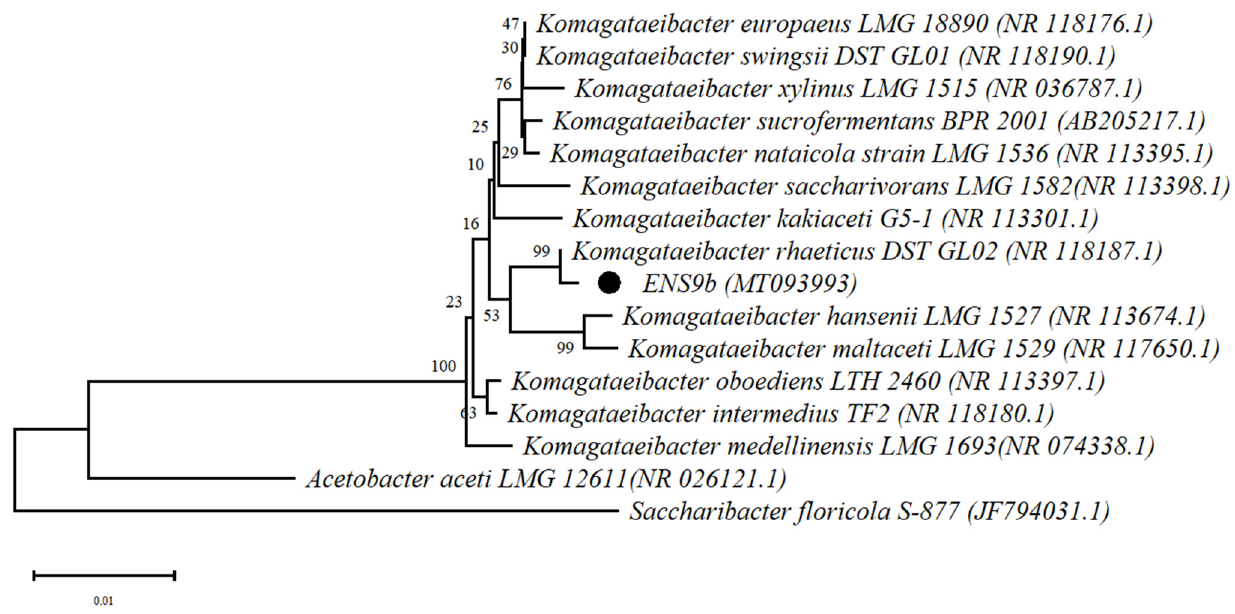
Figure 1. Phylogenetic relationship of ENS9b and Komagataeibacter type strains. The 16S rRNA gene tree was rooted using Saccharibacter floricola S-877 T and Acetobacter aceti LMG 12611 T . The position of ENS9b in the phylogenetic tree is highlighted with a dot. NCBI accession numbers are provided in parenthesis.